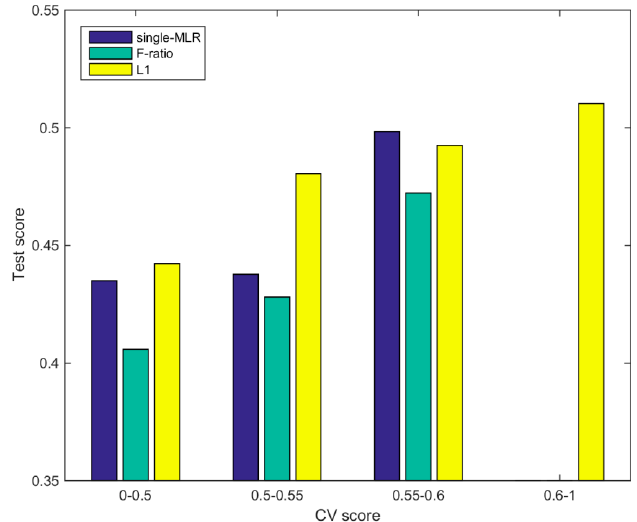
Figure 11. Histogram of the CV scores with respect to test scores in Figure 9 for three schemes,